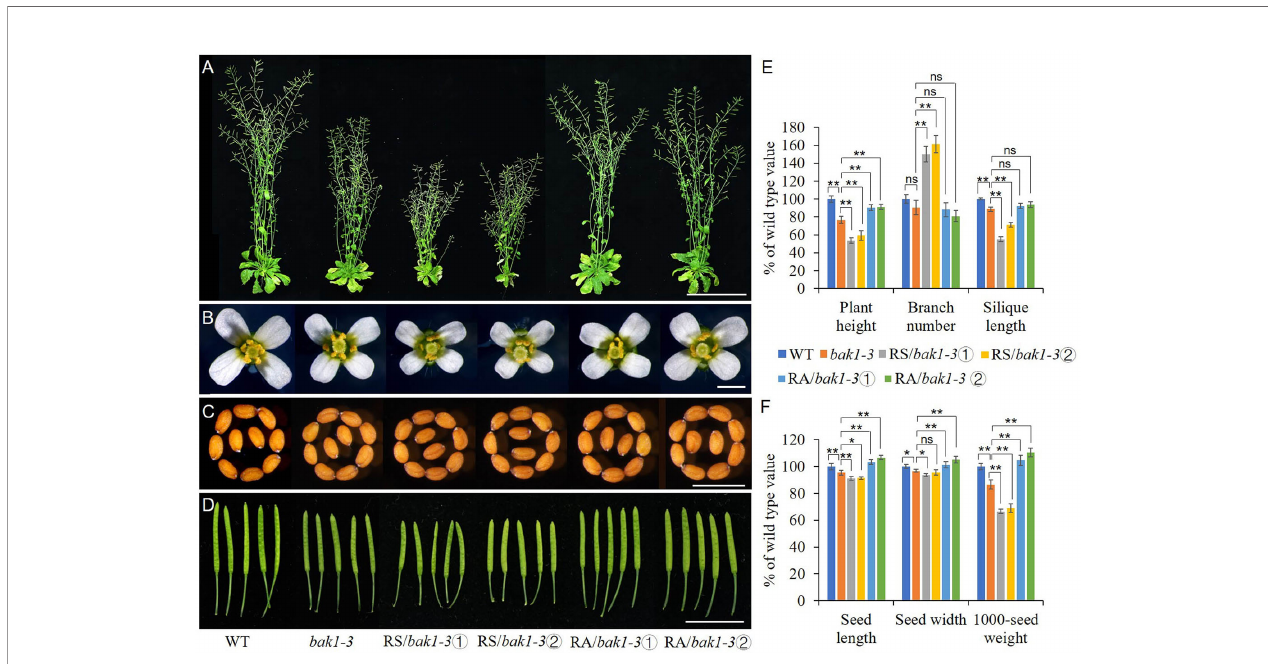
FIGURE 7 | ZmRLK7 acted antagonistically with BAK1 on plant architecture, organ size and 1000-seed weight. (A) Whole morphology. (B) Florets. (C) Seeds. (D) Siliques. (E) Statistical analysis of plant height, branch number and silique lengths. (F) Statistical analysis of seed length, seed width and 1000-seed weight. WT, wild type; RS-3 and RS-5, ZmRLK7 sense transgenic lines; RA-1 and RA-3, ZmRLK7 antisense transgenic lines. Values are means with SD relative to the respective wild-type values. *, ** and ns denote signi fi cant differences at p < 0.05, 0.01 and no signi fi cant difference by ANOVA, respectively. Bars = 10 cm for (A) , 1 cm for (B, D) and 0.5 mm for (C) ,